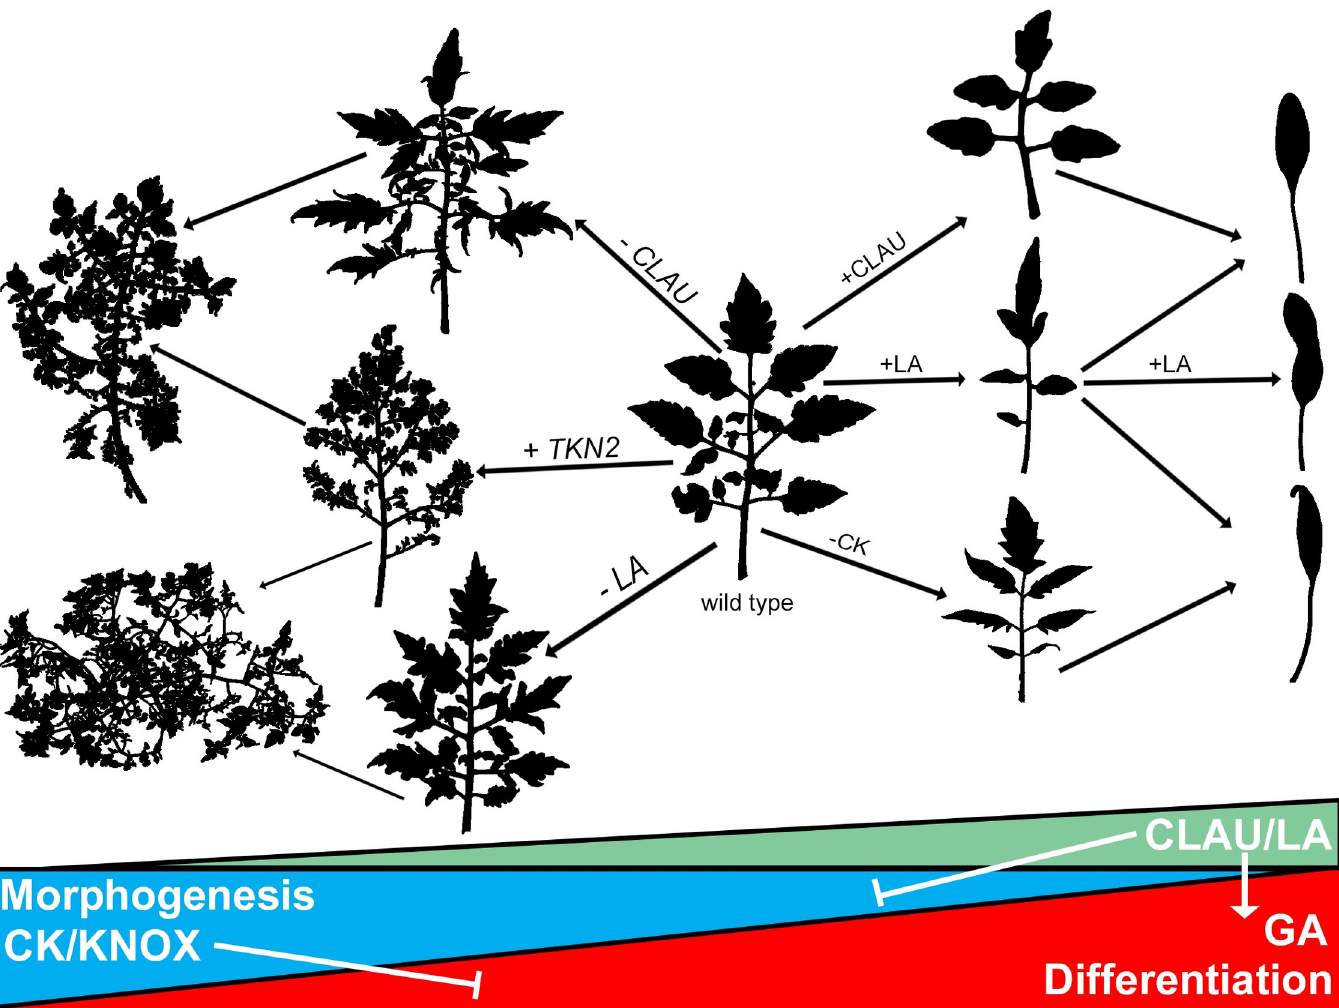
Fig 8. Model for the role of CLAU , LA and TKN2 and GA-CK balance in leaf development. CK promotes morphogenesis, and GA promotes differentiation. Increasing CLAU or LA levels leads to increased GA sensitivity and decreased CK sensitivity, pulls the leaf developmental program towards differentiation, and results in simplified leaf forms. Decreasing CLAU or LA levels leads to increased CK sensitivity and decreased GA sensitivity, pulls the leaf developmental program towards morphogenesis and results in elaborate leaf forms. LA acts in a dose-dependent manner. While only 1 copy of the dominant LA allele in La-2/+ gain-of-function mutants produces some leaflets, adding additional copy of LA allele in the La-2 homozygous plants produces a completely simple leaf. The additional LA copy can be replaced by increasing CLAU levels, by reducing CK levels or by increasing GA levels [39]. Reducing CLAU or LA activity or increasing TKN2 activity leads to increase in leaf complexity, which is further enhanced when combining two of